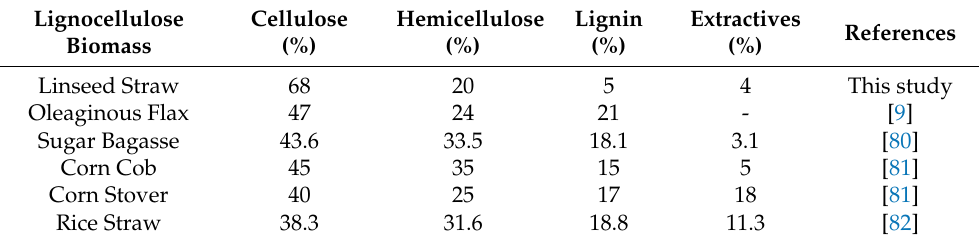
Table 4. Chemical composition of lignocellulose biomasses from agricultural wastes.